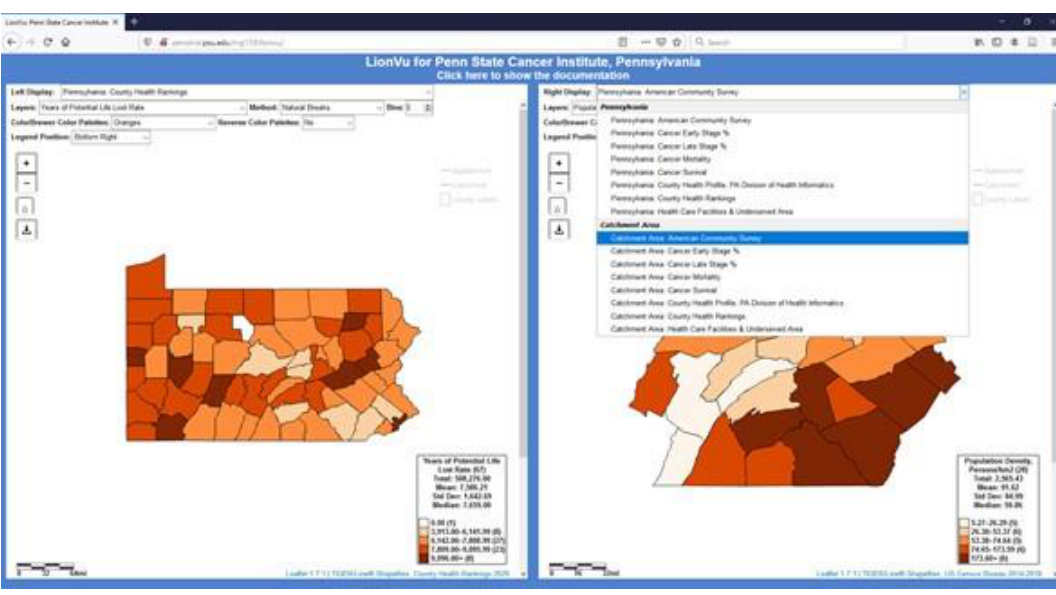
Figure 8. LionVu 2.1 tool using seven dropdown menus and a button to download maps, while preserving side-by-side displays. Left display: Years of potential life lost rate within Pennsylvania. Right display: Population density within catchment area.